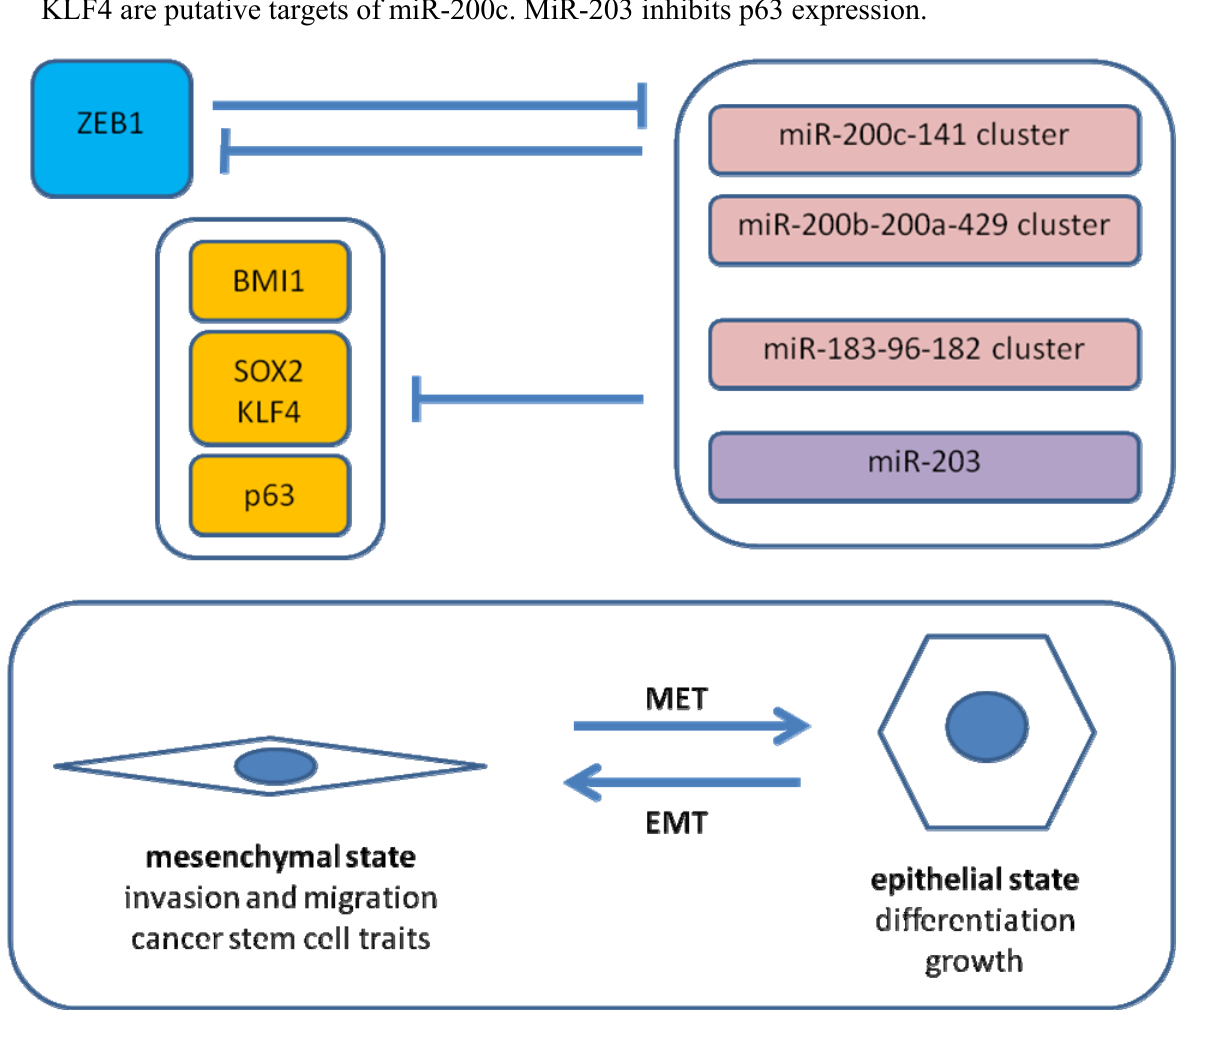
Figure 2. ZEB1-microRNA interactions in EMT. Shown is a simplified scheme of regulatory loops in EMT of cancer cells. A direct negative feedback loop between ZEB1 and the miR-200c-141 cluster stabilizes either the epithelial or the mesenchymal state. ZEB1 expression results in downregulation of the miR-200 family, miR-203 and miR-183. MiR-200c, miR-203 and miR-183 cooperatively inhibit BMI1 expression. SOX2 and KLF4 are putative targets of miR-200c. MiR-203 inhibits p63